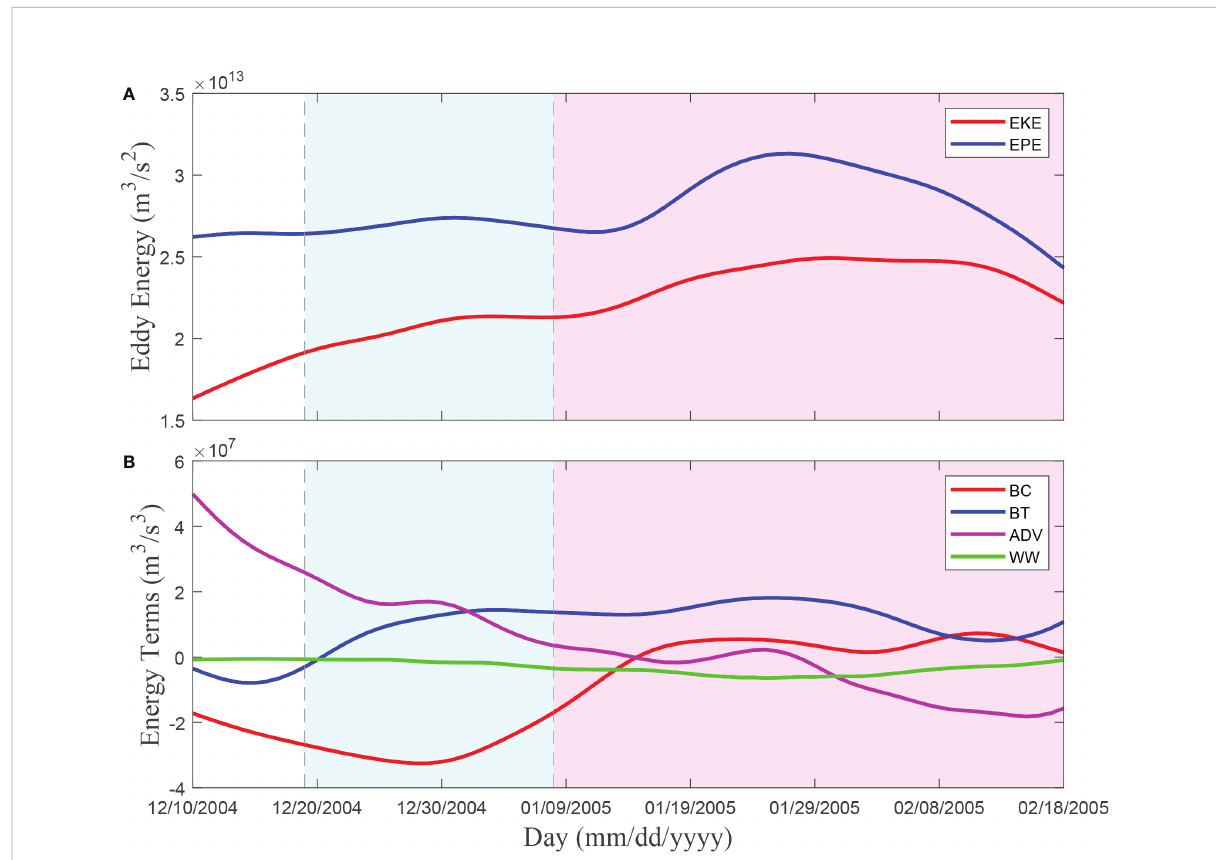
FIGURE 8 Time series of the plane integrals of the energy terms in the region where the eddy is located (black box in Figure 7). (A) shows eddy kinetic energy (EKE) and eddy potential energy (EPE), and (B) shows baroclinic conversion (BC), barotropic conversion (BT), advective term (ADV), and wind stress work (WW) values. White, cyan and pink background color indicate the periods of generation, separation, and stabilization,